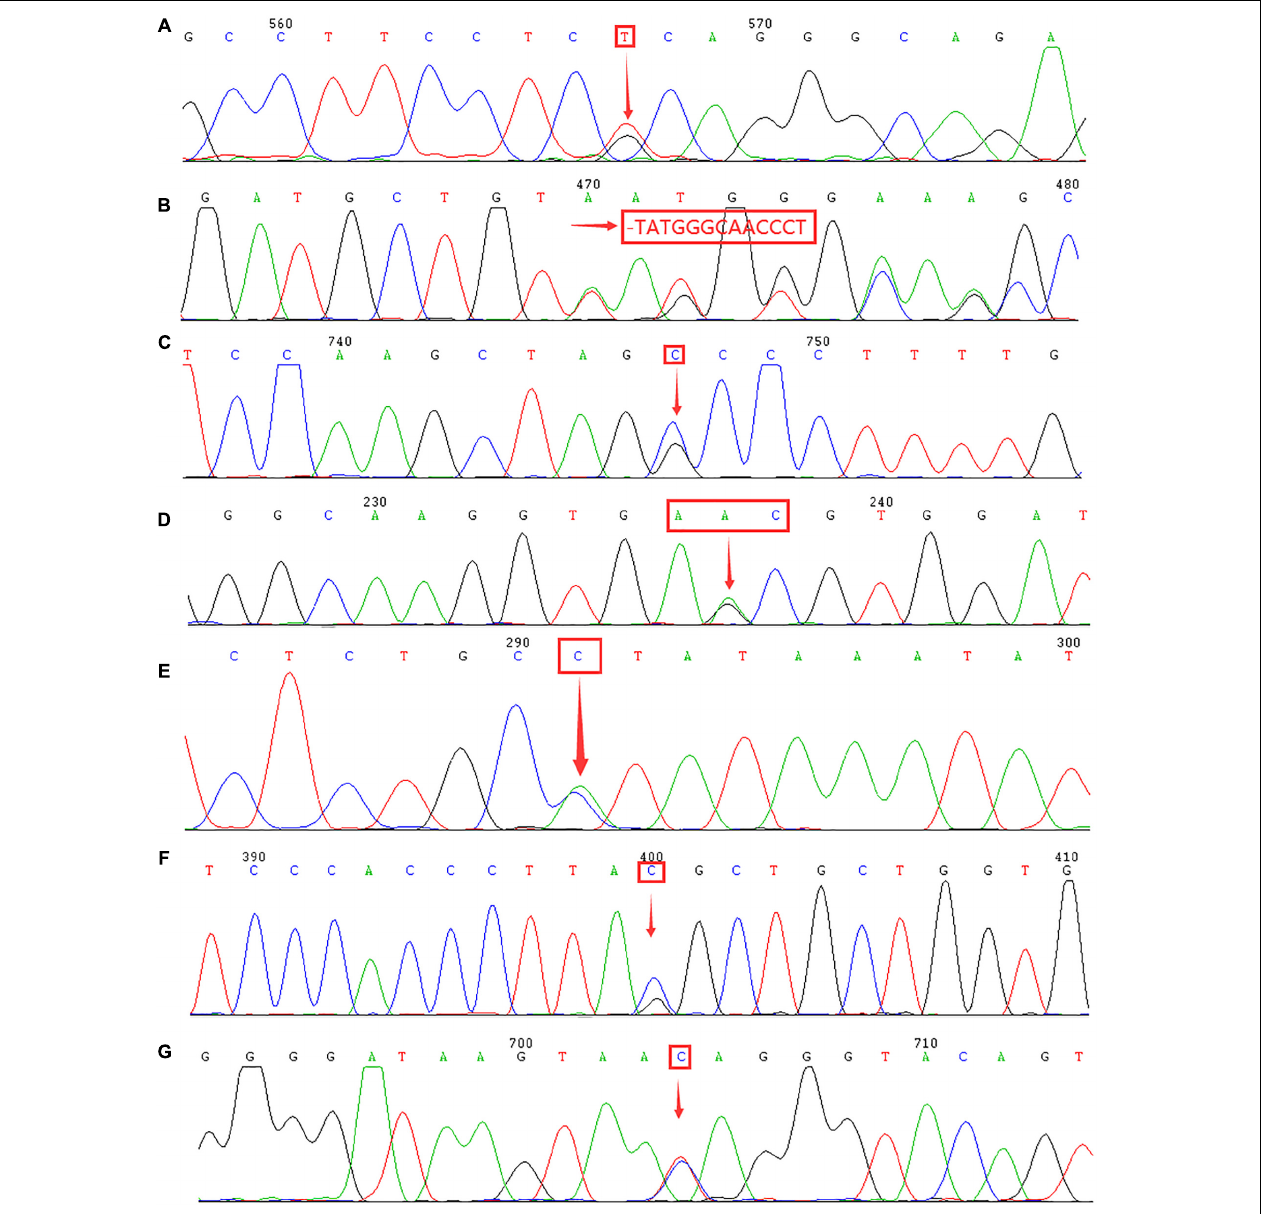
FIGURE 2 | Identification of rare α - and β -thalassemia mutations using DNA sequencing. Arrows indicate the location of the mutations. (A) IVS-II-55(T > G) mutation in the HBA2 gene. (B) CD54-58(-TATGGGCAACCCT) mutation in the HBB gene. (C) IVS-II-806(G > C) mutation in the HBB gene. (D) Hb Malay(AAC > AGC) mutation in the HBB gene. (E) IVS-II-672(A > C) mutation in the HBB gene. (F) IVS-I-130(G > C) mutation in the HBB gene. (G) IVS-II-81(C > T) mutation in the HBB gene.